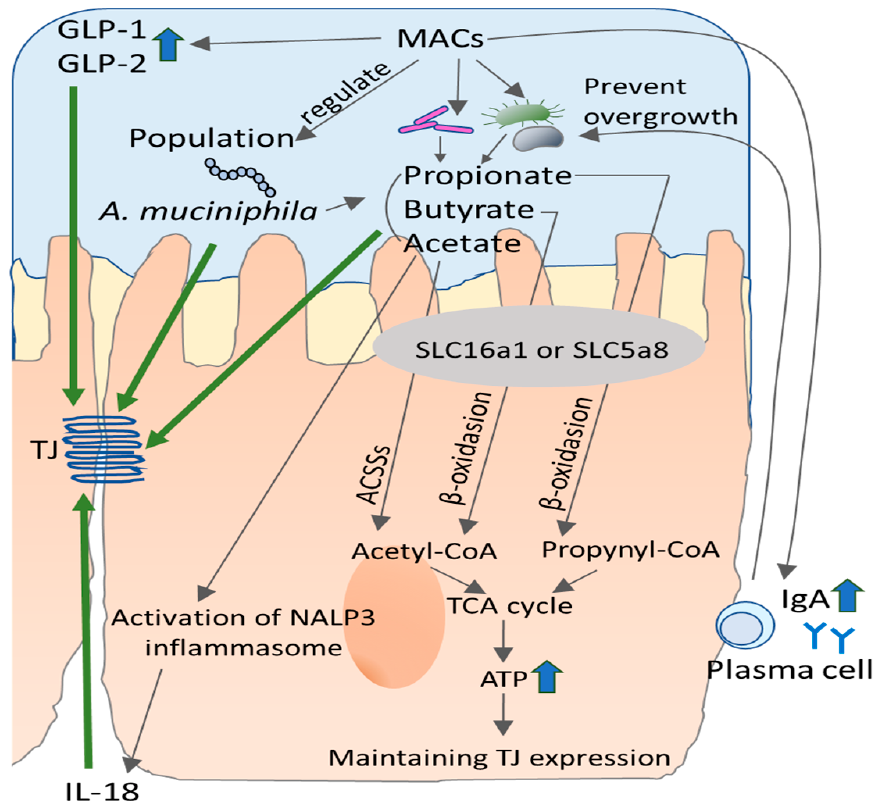
Figure 4. Effects of microbiota-accessible carbohydrates (MACs) on tight junction (TJ). Intestinal bacteria digest fermentable MACs and produce short-chain fatty acids (SFCA) which are absorbed into epithelial cells via solute carrier family (SLC) transporter or simple diffusion. Acetate, butyrate, and propionate are converted to acetyl-CoA or propynyl-CoA via acetyl-CoA carboxylases (ACSSs) or β -oxidation to produce ATP which maintain cell homeostasis including the function of TJ.